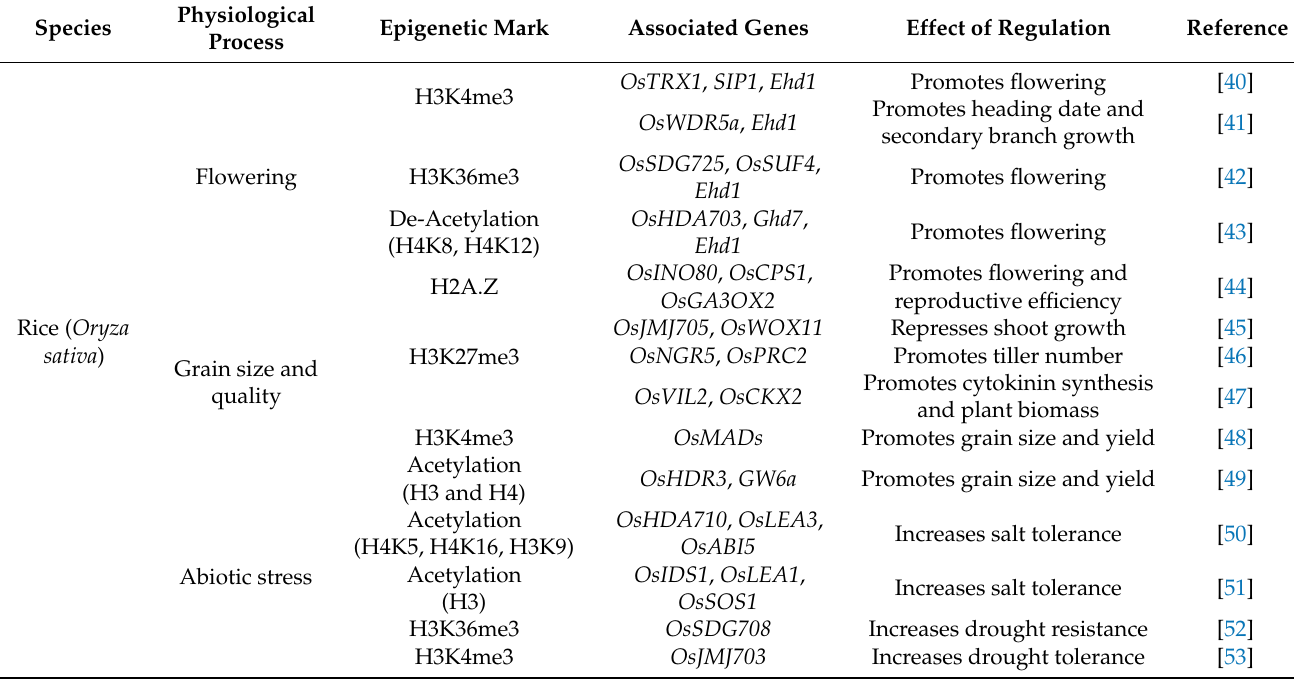
Table 1. List of histone modification markers and the associated physiological processes in rice and